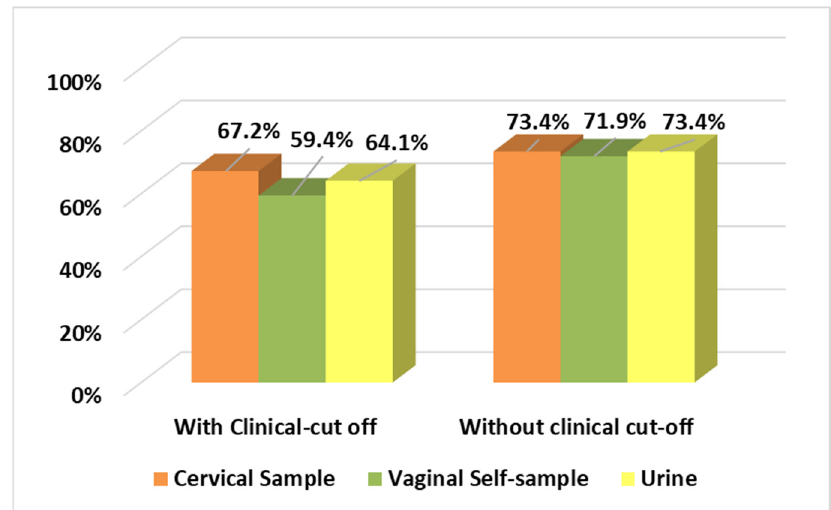
Figure 1. HPV positivity analysed considering and not considering clinical cut-off.